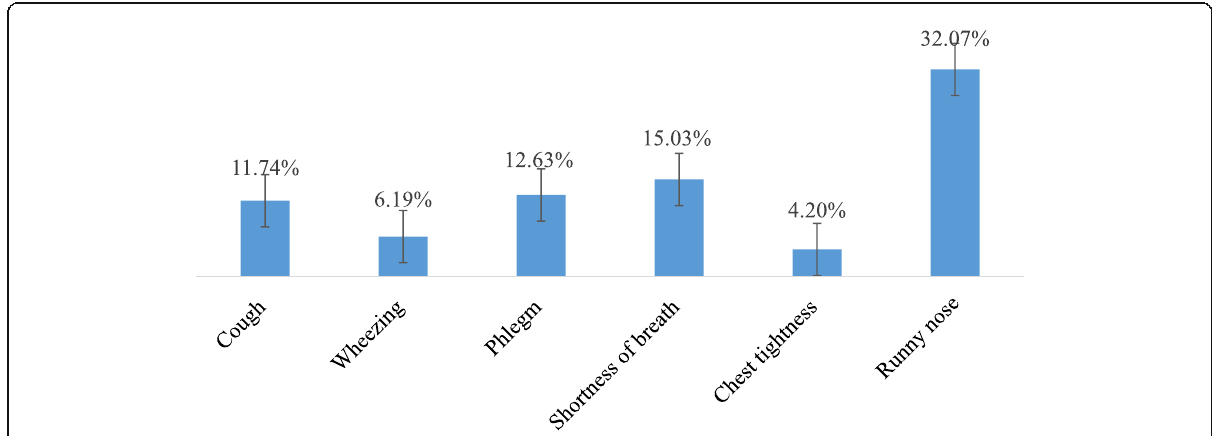
Fig. 3 Prevalence of respiratory symptoms among mothers in Gondar city, northwest Ethiopia,